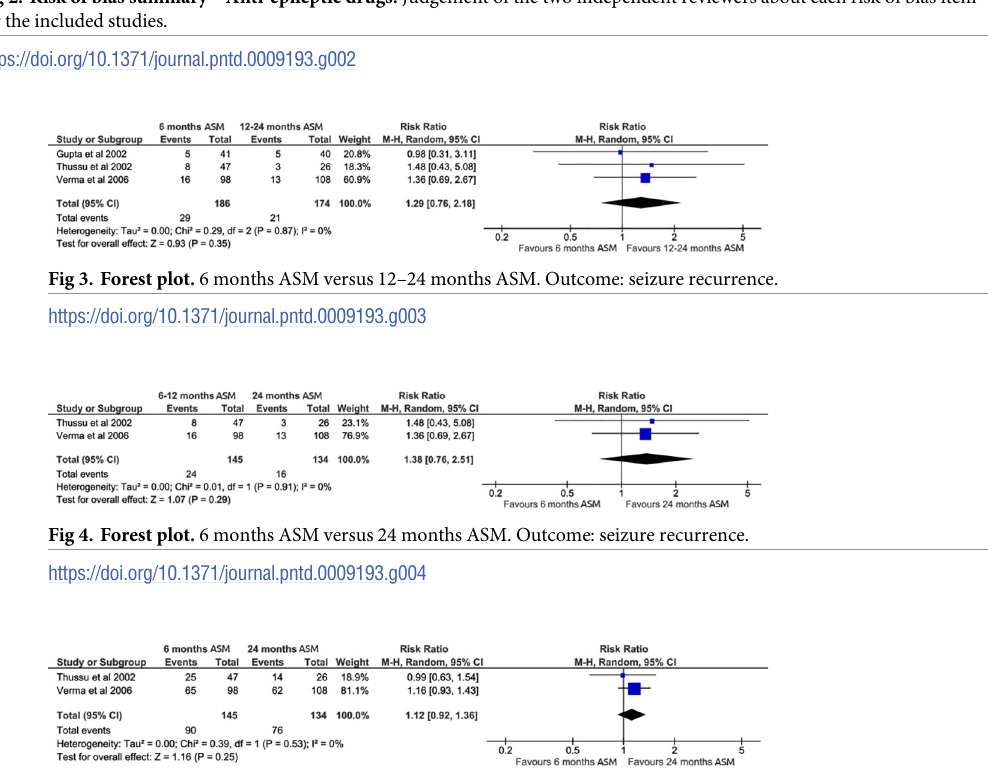
Fig 5. Forest plot. 6 months ASM versus 24 months ASM. Outcome: Cyst resolution.